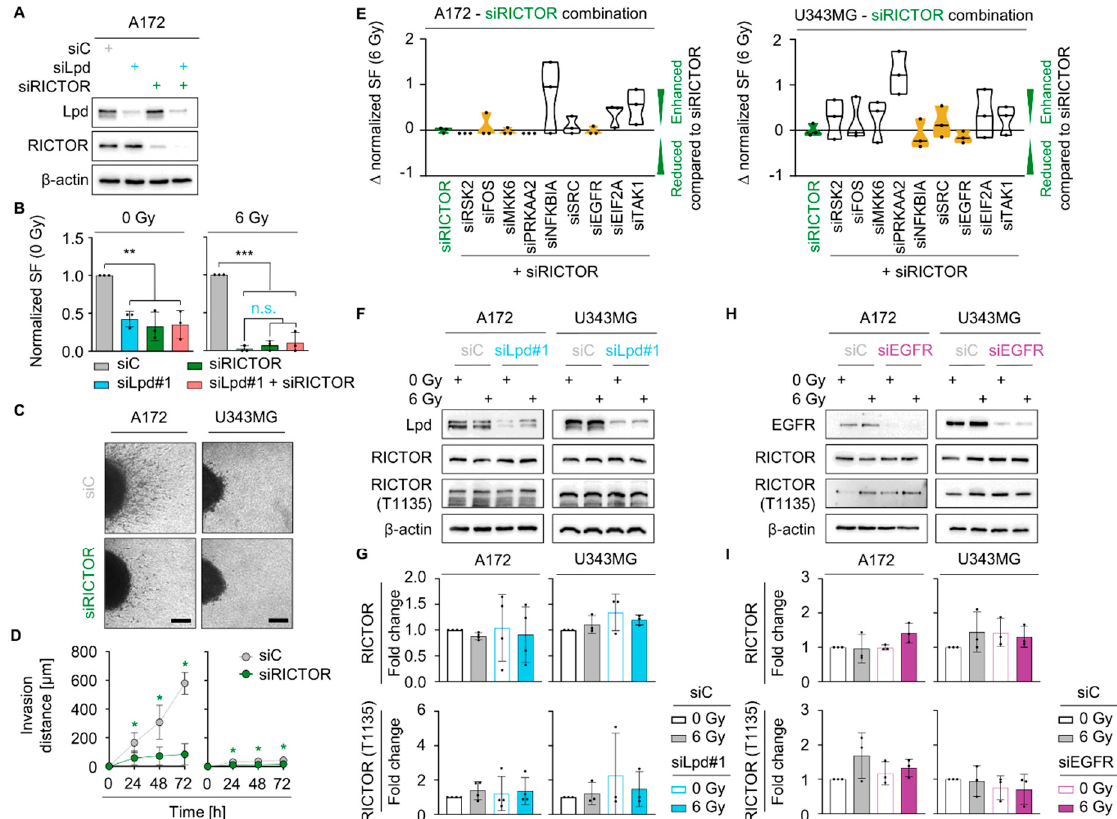
Figure 6. Lamellipodin and RICTOR jointly regulate invasion and radiosensitivity in glioblastoma cells. ( A ) Representative Western blot and ( B ) normalized surviving fraction of non-irradiated and 6 Gy irradiated A172 cells upon Lpd and RICTOR knockdown. ( C ) Representative images of spheroids in 3D collagen I matrix 72 h after seeding. ( D ) Invasion at 24 h, 48 h and 72 h of control and RICTOR siRNA treated A172 and U343MG. ( E ) Differences in radiosensitizing effects shown by ∆ values of normalized surviving fraction 6 Gy upon knockdown of the indicated proteins subtracted by RICTOR knockdown in A172 and U343MG cells. ∆ value describes an altered survival relative to the survival of siRICTOR and 6 Gy treated cells: <0 reduced survival, 0 equal survival, >0 increased survival. Yellow color displays similar survival at 6 Gy comparable to RICTOR knockdown, whereas white color mark a differing survival. ( F ) Western blots of Lpd, RICTOR, phospho-RICTOR T1135 and β -actin in Lpd silenced A172 and U343MG cells 1 h after 0 Gy and 6 Gy irradiation. ( G ) Densitometry of RICTOR and phosphorylated RICTOR T1135 from ( F ). Fold changes of RICTOR levels are calculated by normalization to β -actin. Fold changes of phosphorylated RICTOR are determined by normalization to total RICTOR expression. All protein levels are related to the corresponding β -actin. Fold changes are relative to control-treated and unirradiated samples. ( H ) Representative immunoblot showing RICTOR and RICTOR T1135 upon EGFR knockdown and 1 h after irradiation in A172 and U343MG. Actin served as loading control. ( I ) Fold changes of total RICTOR and phosphorylated RICTOR T1335 calculated from ( H ). Fold changes of RICTOR levels are calculated by normalization to β -actin. Fold changes of phosphorylated RICTOR are determined by normalization to total RICTOR expression. All protein levels are related to the corresponding β -actin. Fold changes are relative to control treated and unirradiated samples. All results are presented as mean ± SD ( n = 3–4, two-sided Student’s t -test, n .s., not significant, * p < 0.05, ** p < 0.01, *** p < 0.001). si, small interfering RNA; C, control; Lpd, Lamellipodin; SF, surviving